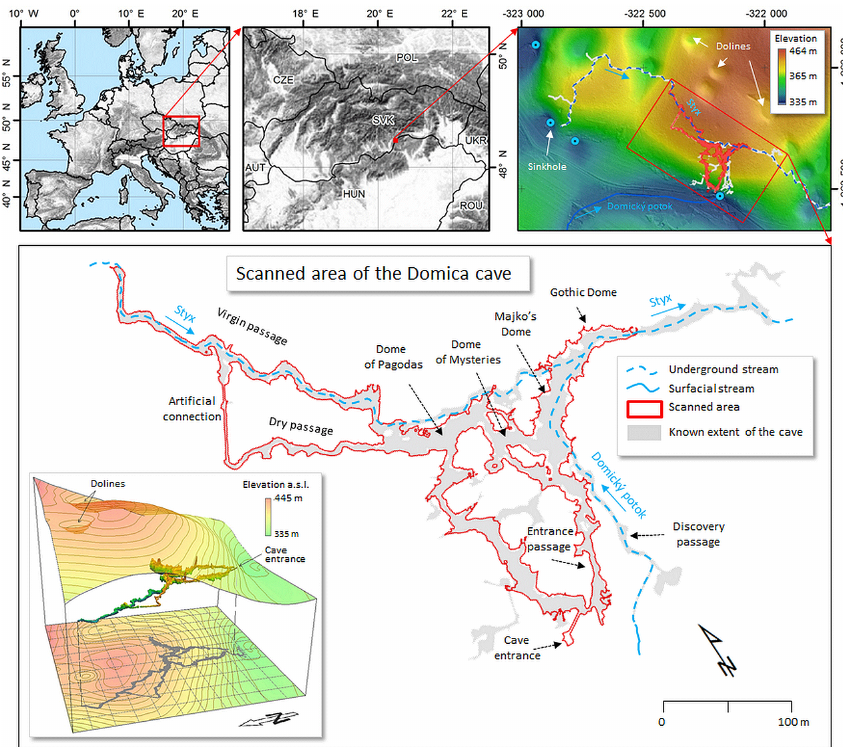
Figure 3. Location of the scanned part of the Domica cave with orthogonal projection of the Domica–Baradla cave system according to Droppa